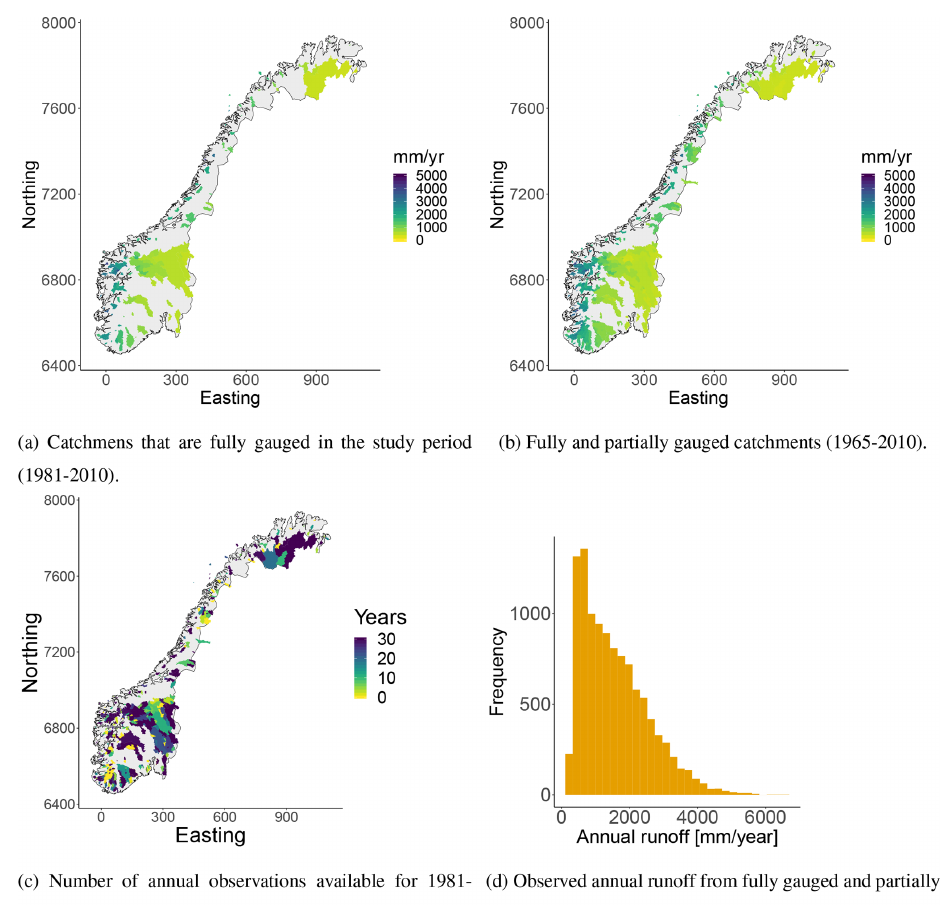
Figure 1. Mean annual runoff for Norwegian catchments (a–b) derived from daily streamflow observations. There are annual runoff data available from 127 fully gauged catchments and from 284 partially gauged catchments. We plot subcatchments in front of larger, surrounding catchments in all of our plots. (c) Number of annual observations that are available for each catchment in the study period (1981–2010). If the number is equal to 0, it means that there is at least one annual observation available from 1980 or earlier years, more specifically between 1965 and 1980. The reference system used is UTM33N EUREF89 with coordinates given in kilometers. (d) Annual observations for all catchments and